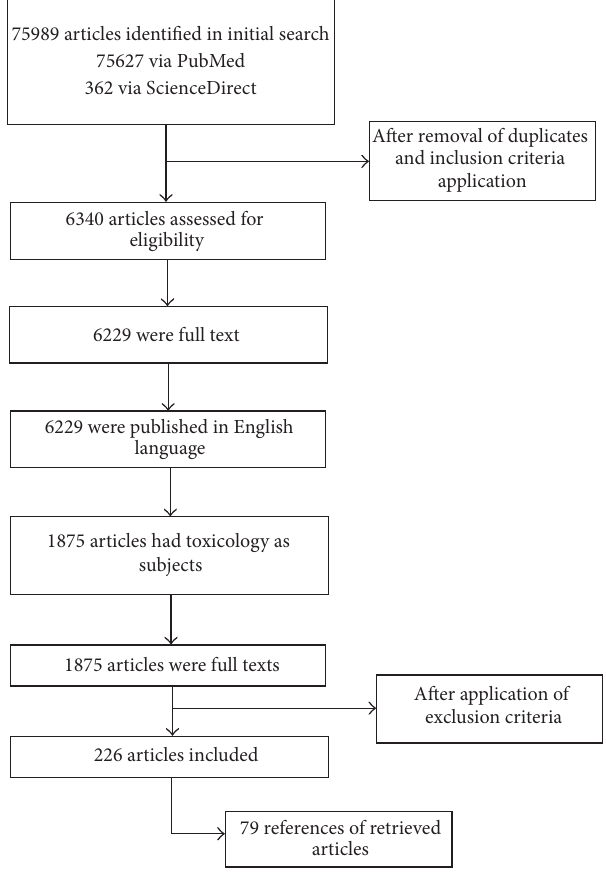
Figure 1: Flow of papers identified from search